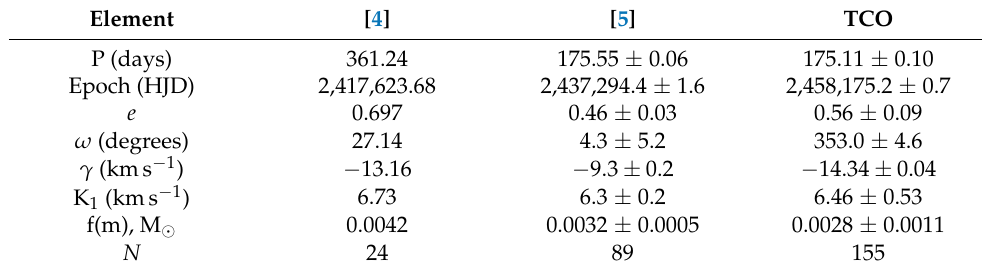
Table 1. Orbital elements derived for MizarB (HR 5055).